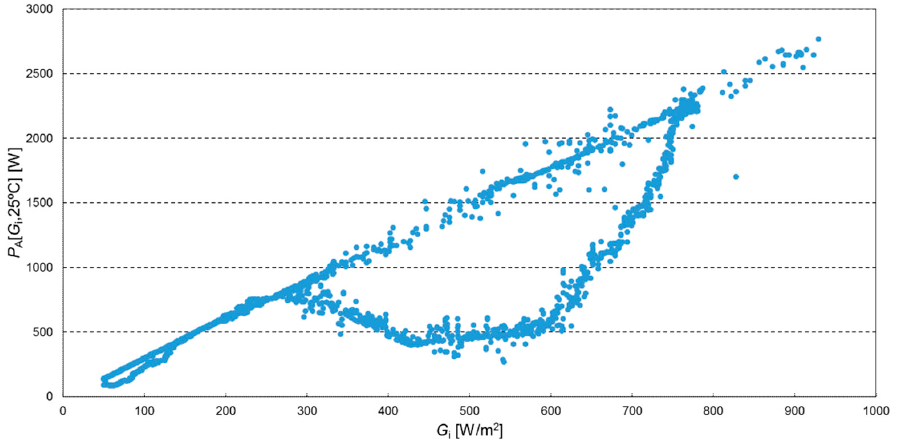
Figure 10. Values of the power output of the PV field of PVGCS #2 corrected at 25 °C ( P A [ G i , 25 °C], in W) vs. in-plane irradiance over a full day (06/28/2016). The sublinear behavior clearly distinguished between 300 and 800 W·m − 2 is caused by a shade cast over the PV field. The shading impact of a surrounding element on the PV output is also noticeable below 200 W·m − 2 .